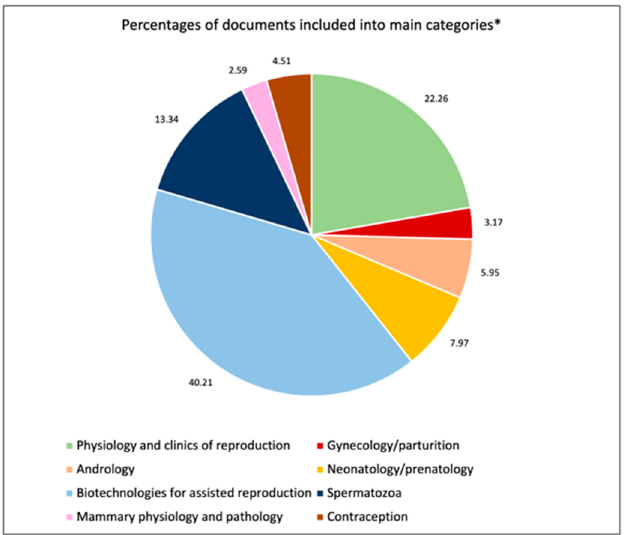
Figure 7. Distribution of documents included in the present study into EVSSAR (European Veterinary Society for Small Animal Reproduction) “selected papers” section (2020). *: “Biotechnologies for assisted reproduction” and “Physiology and clinics of reproduction” are the categories that include the highest percentage of documents.